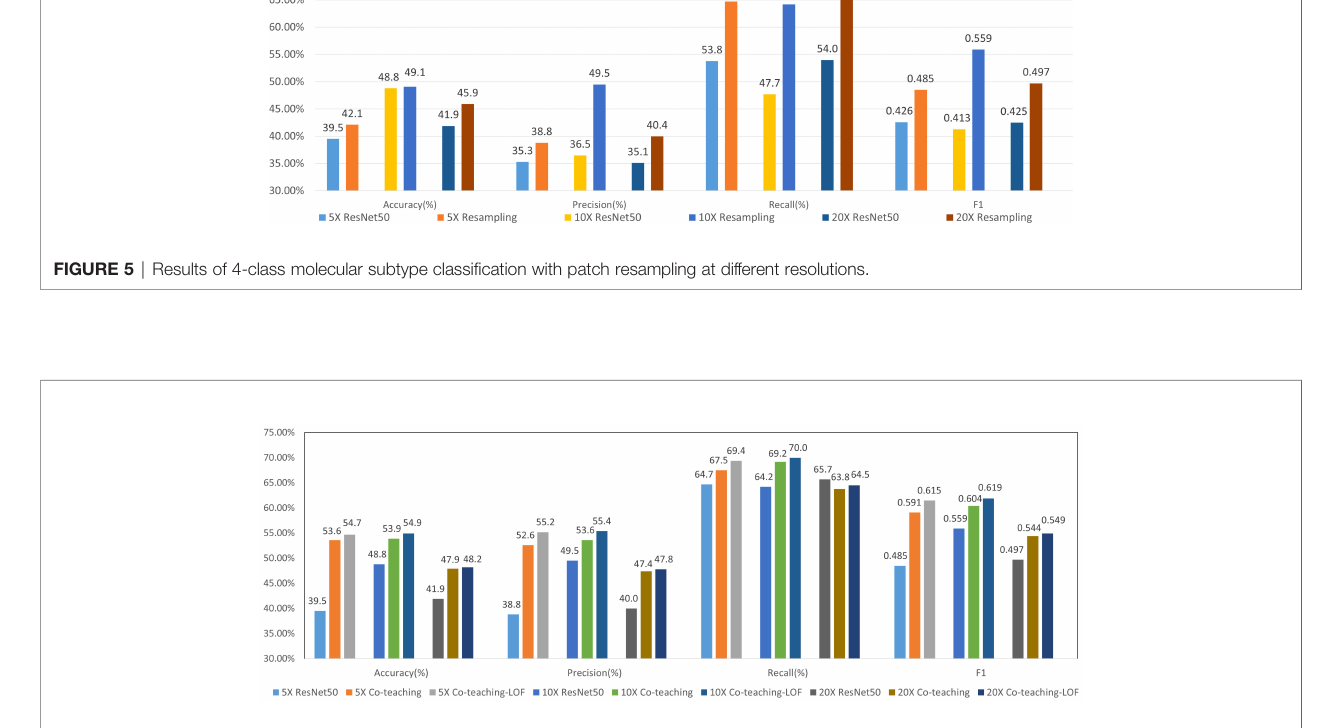
FIGURE 6 | Results of 4-class molecular subtype classi fi cation with co-teaching and LOF at different resolutions.